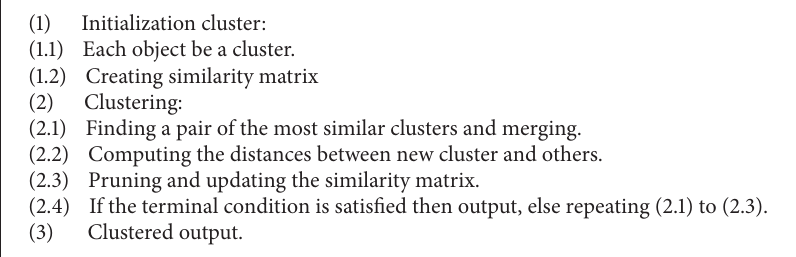
Algorithm 3: Clustering algorithm.